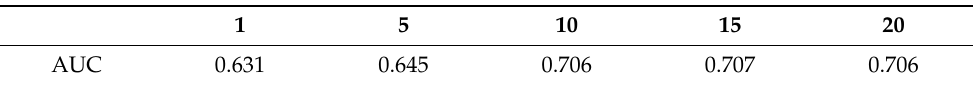
Table 2. Visual tracking performance of the proposed OPV according to values of c in (8). 1